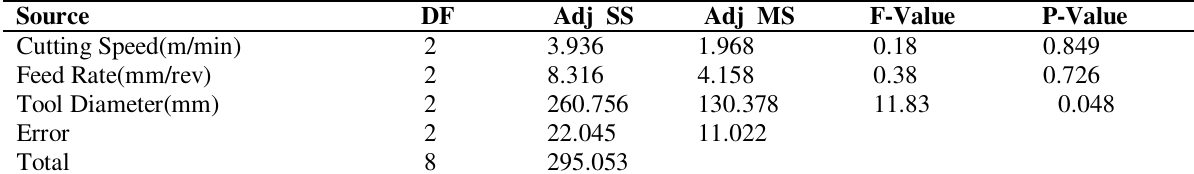
Table 8, The Result of ANOVA of S/N ratio for (Ra).